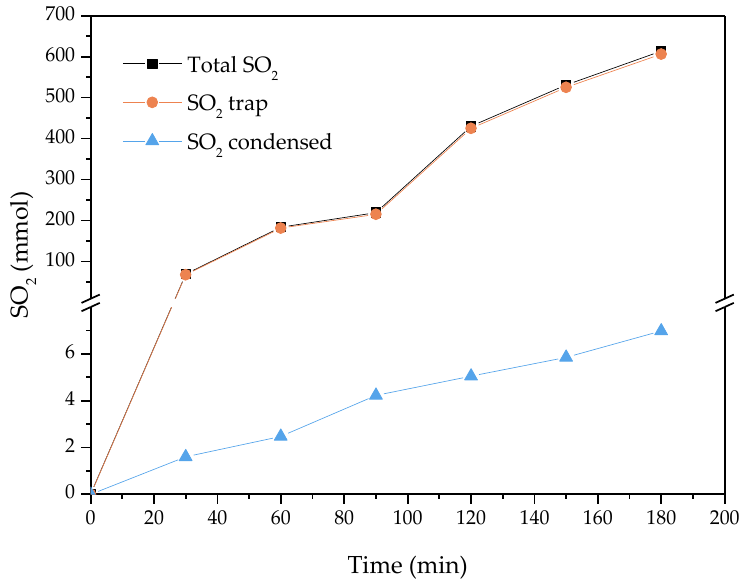
Figure 2. The SO 2 amount produced in the catalytic decomposition of H 2 SO 4 using 1 g of CuO at 1173 K.